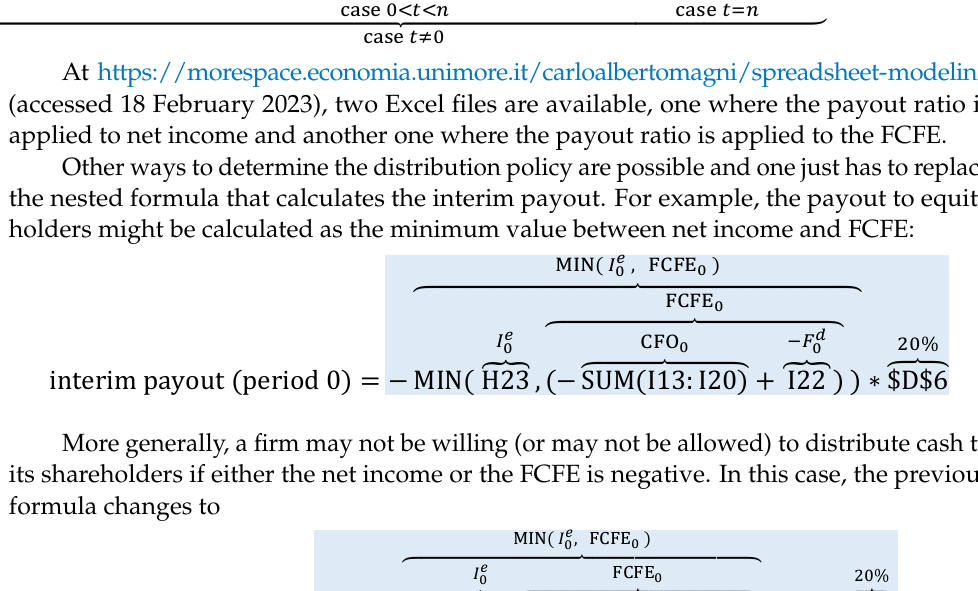
Figure A1. An alternative way to determine the Cash Flow to Equity in cell I23 (“SplitScreenStrip” sheet).